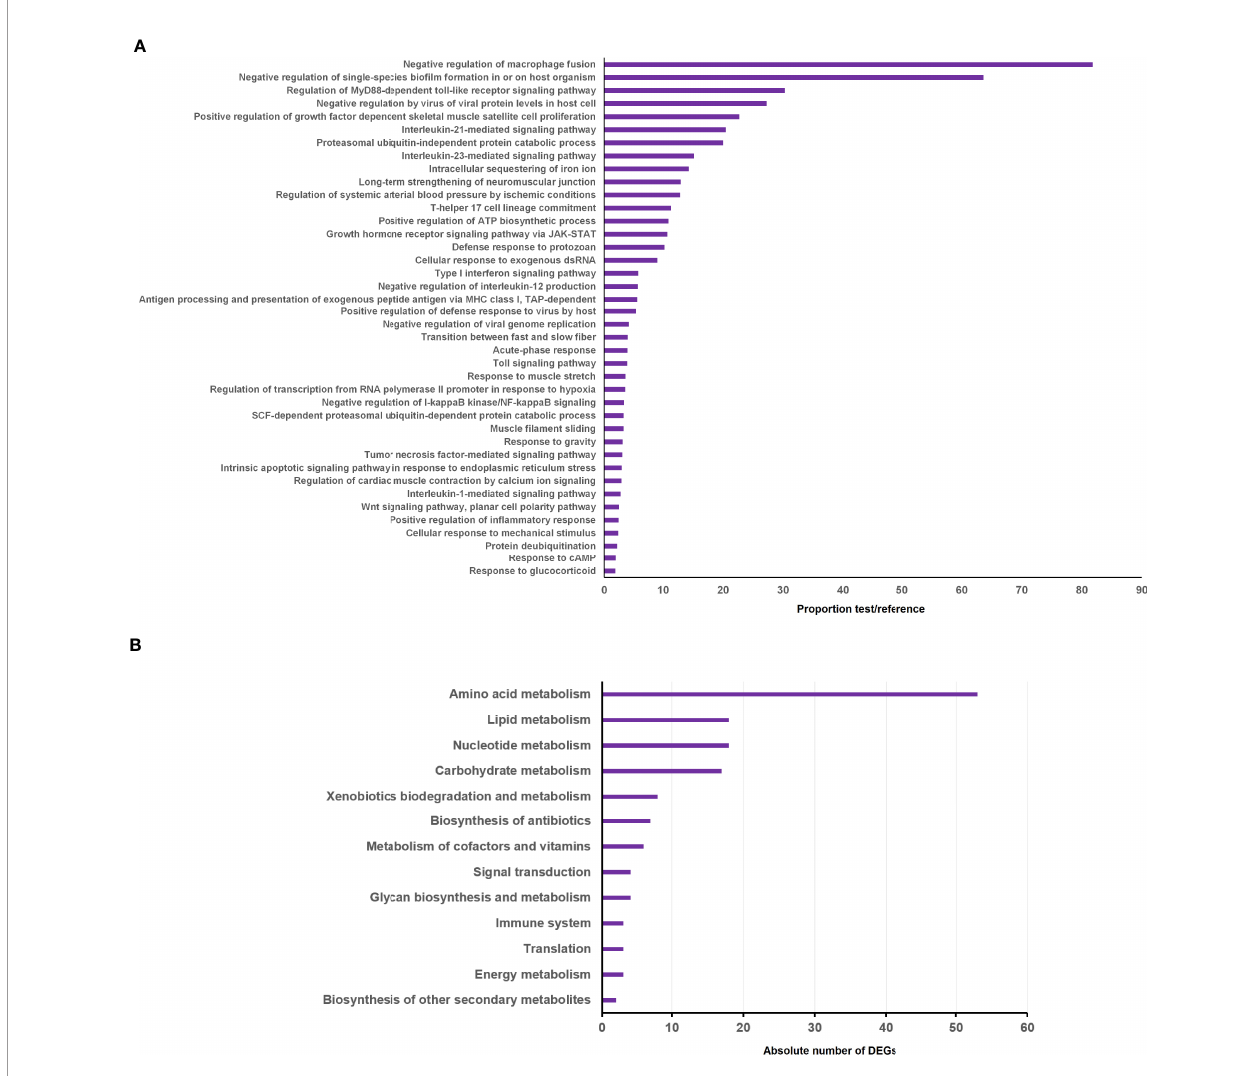
FIGURE 3 | Enrichment analysis of the genes differentially expressed in head kidney after A salmonicida challenge compared to the uninfected controls. (A) GO enrichment analysis showing the 40 most signi fi cantly enriched biological processes. (B) KEGG pathways enriched for the signi fi cantly modulated